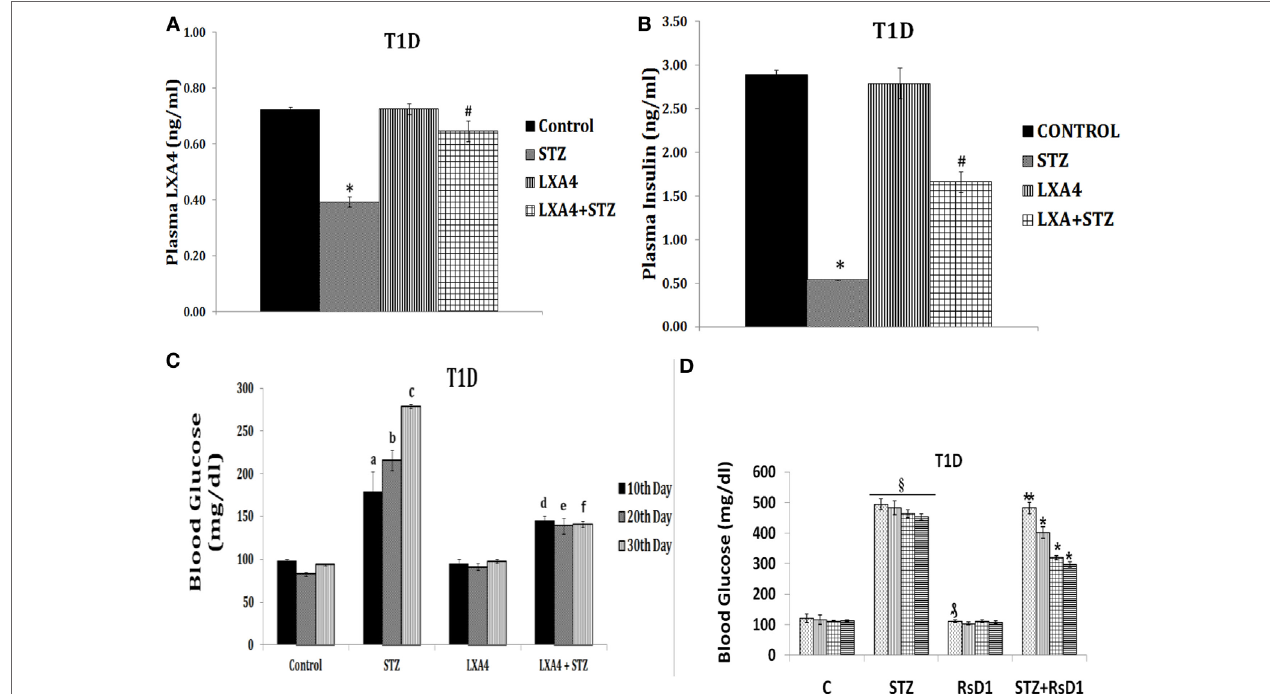
FiGUre 8 | Effect of lipoxin A4 (LXA4) on streptozotocin (STZ)-induced type 1 diabetes mellitus (type 1 DM) (a–C) and resolvin D1 on STZ-induced type 1 DM (d) [these data are taken from Ref. (137) and unpublished data]. These studies were approved by Institutional Animal Ethics committee. T1D = type 1 DM. After 7 days of acclimatization, animals received 60 ng/ml LXA4 intraperitoneally for 5 days and 45 mg/kg body weight of STZ only on day 1. (a) Plasma LXA4 levels measured on day 30 of the study . (B) Plasma glucose levels : plasma glucose estimation was performed once in 10 days until the end of the study. All values are expressed as mean ± SEM. a P ≤ 0.05 compared to 10th day control values; b P ≤ 0.05 compared to 20th day control values; c P ≤ 0.05 compared to 30th day control values; d P ≤ 0.05 compared to 10th day STZ values; e P ≤ 0.05 compared to 20th day STZ values; f P ≤ 0.05 compared to 30th day STZ values; * P ≤ 0.05 compared to untreated control; # P ≤ 0.05 compared to STZ control. All values are expressed as mean ± SEM. (C) Plasma insulin levels : plasma insulin levels were estimated on day 30. All values are expressed as mean ± SEM. * P ≤ 0.05 compared to untreated control; # P ≤ 0.05 compared to STZ. (d) Plasma glucose levels in STZ-induced type 1 DM treated with resolvin D1 (derived from DHA) . * P < 0.05 compared to